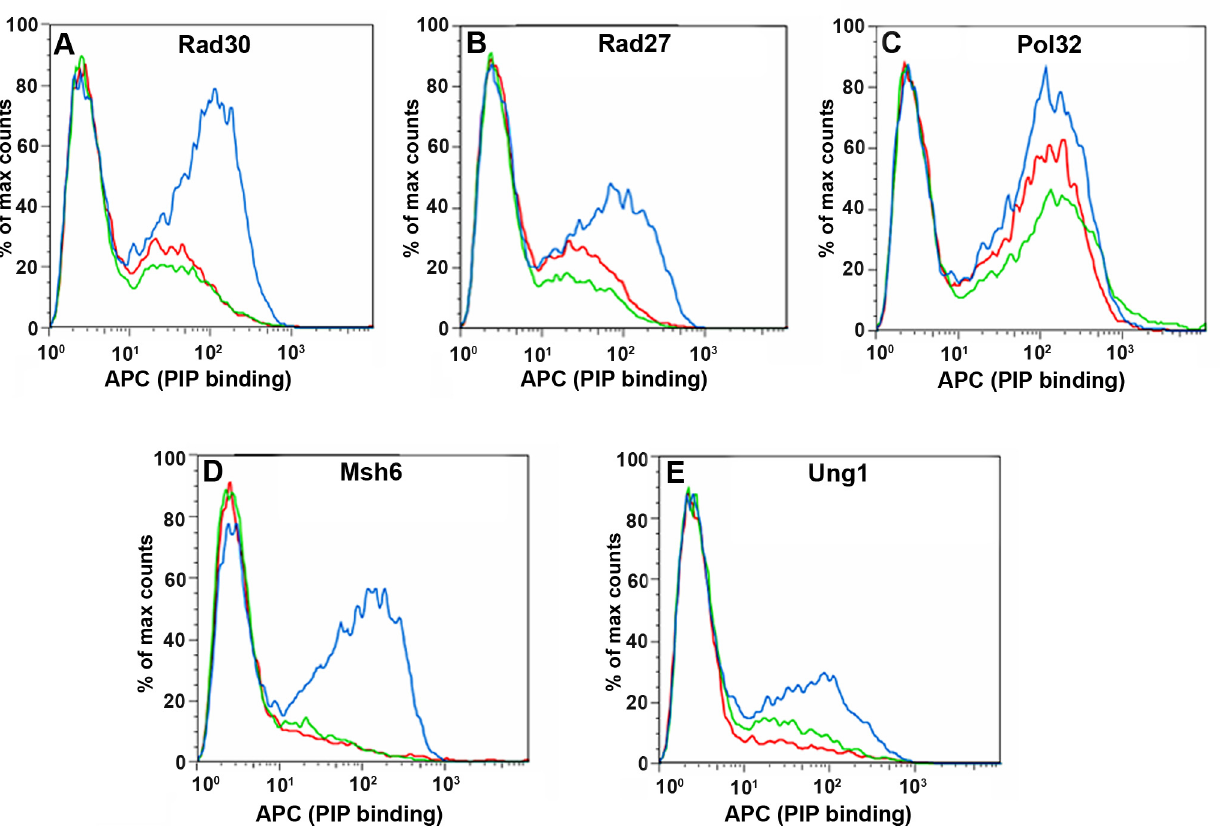
Figure 3. Enrichment of PCNA libraries displayed on the yeast cell surface for mutants exhibiting increased affinity for the target PCNA partners, as assessed by flow cytometry. FACS histogram analysis of cells displaying wild-type PCNA (red), a naı¨ve library (green), and libraries following 3–5 rounds of enrichment (blue), following incubation with biotinylated PIP peptide derived from Rad30 (A), Rad27 (B), Pol32 (C), Msh6 (D), or Ung1 (E). Binding of PIP peptides was measured following subsequent incubation with allophycocyanin (APC)-labeled streptavidin ( x -axis).